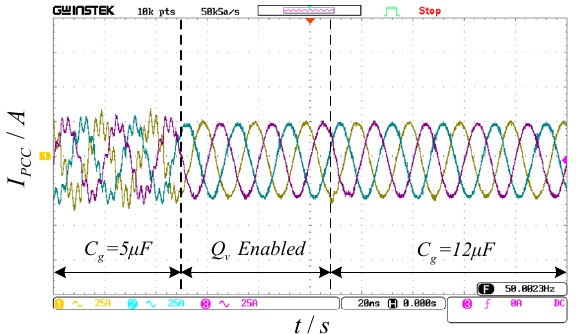
Figure 26. Experimental result of current waveform at PCC before and after reshaping.